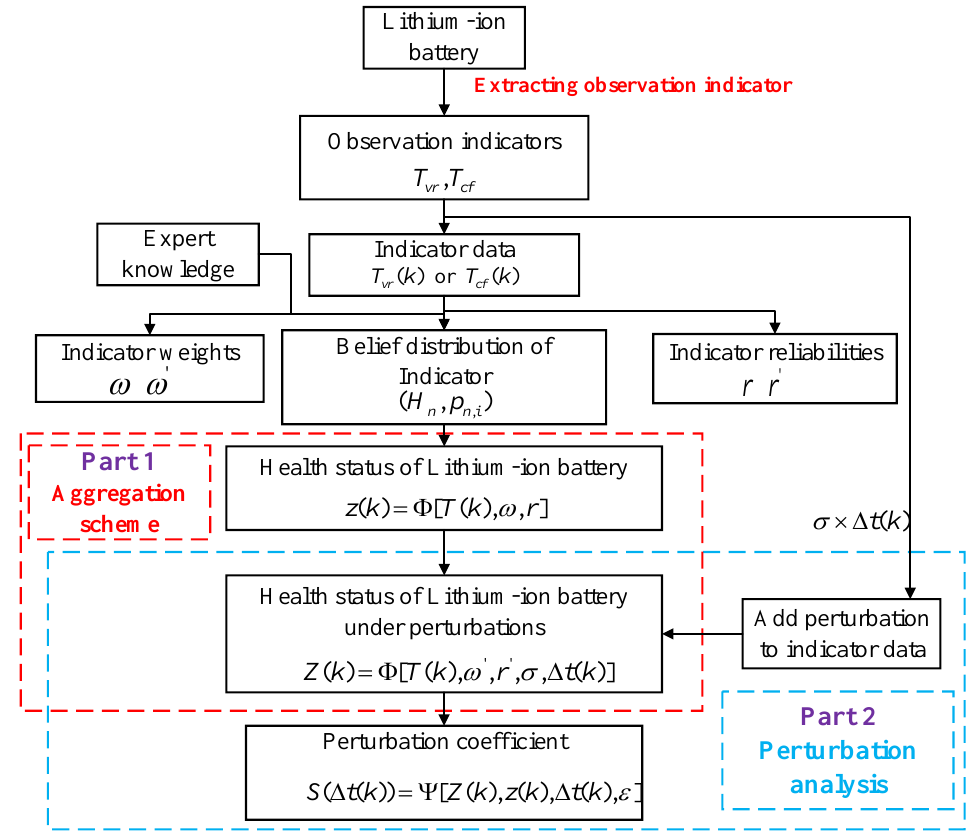
Figure 1. Process for assessing lithium-ion battery health status. In Figure 1, the observed indicators are taken as input data for the assessment model. Weights and reliabilities of indicators are calculated from these indicators. In part 1, evi- dence is generated from the observed indicator data, and we introduce an aggregation approach that allows the evidence, weights, and reliability to be fully integrated into the health assessment results. In part 2, the perturbations are added to the indicator data, the perturbation coefficient is calculated as the basis of the lithium- ion battery’s reliability.